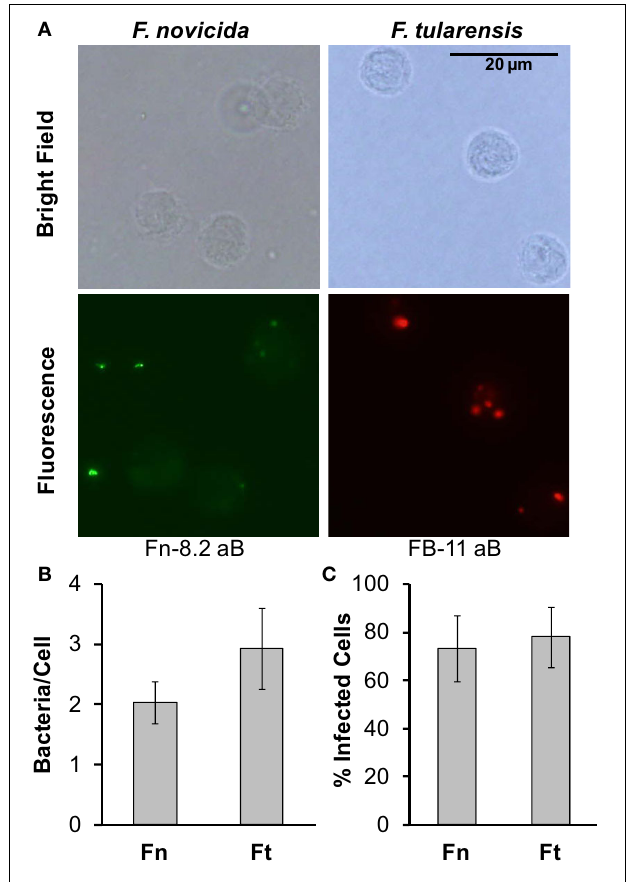
FIGURE 2 | F. novicida and F. tularensis associate similarly with monocytes during infection. Primary human monocytes were infected with F. novicida (Fn) or F. tularensis Schu S4 (Ft) at an MOI of 50 for 5h. (A) Representative images from cells fixed in paraformaldehyde and then stained with Fn-82 antibody specific for F. novicida or FB-11 antibody specific for F. tularensis . The corresponding secondary antibody for Fn-82 was Alexa Fluor 488 rabbit anti-goat IgG (green) and for FB-11 it was AlexaFluor 594 goat anti-mouse IgG (red). Graphs represent the number of bacteria per cell (B) or the number of infected cells (C) . Graphs represent the mean ± s.e.m. from 1 donor incorporating a minimum of 4 frames. Data were analyzed by Student’s t -test. No significant differences were found.